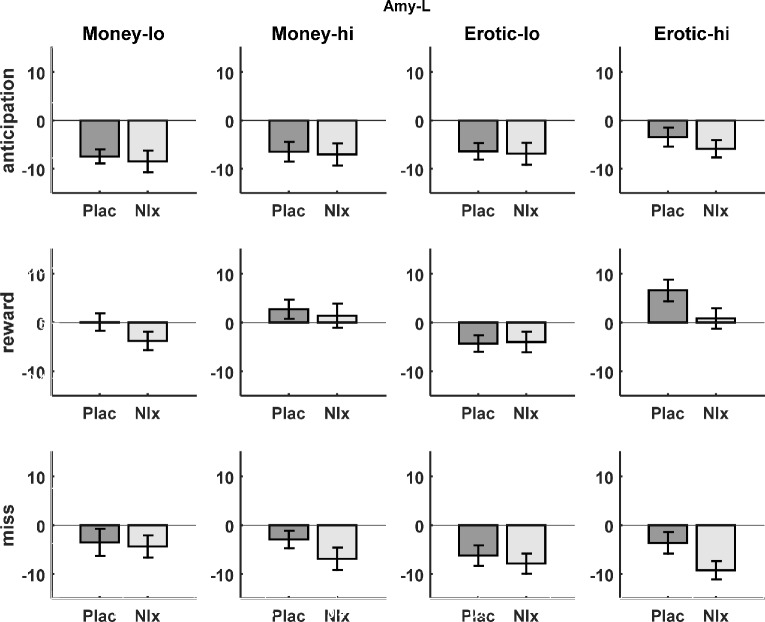
Left amygdala fMRI responses (arbitrary units) for all stimuli (money/erotic, high/low) and time-points (anticipation, outcome: reward, outcome: miss) under placebo (Plac) and naloxone (Nlx).Error bars represent standard error of the mean.